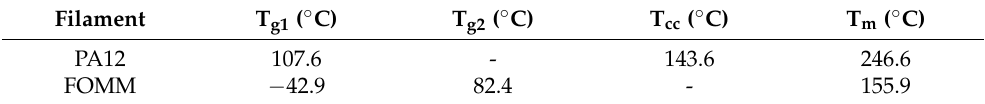
Figure 5. Heat flux curves obtained for PA12 and FOMM filaments, as received. Table 2. Transition temperatures obtained by DSC of the filaments.